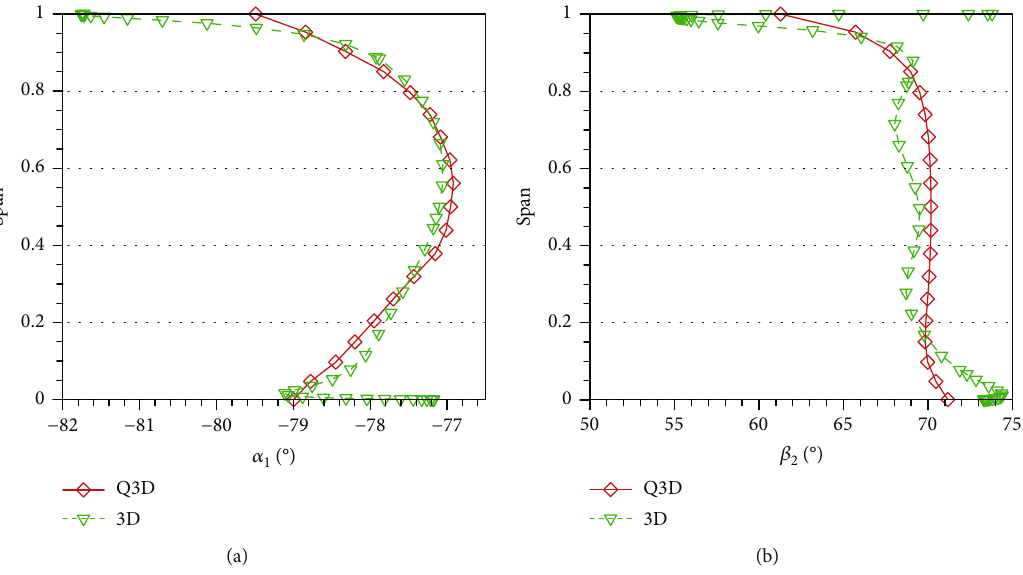
Figure 21: Flow angle of the single-stage turbine: (a) stator fl ow angle; (b) rotor relative fl ow